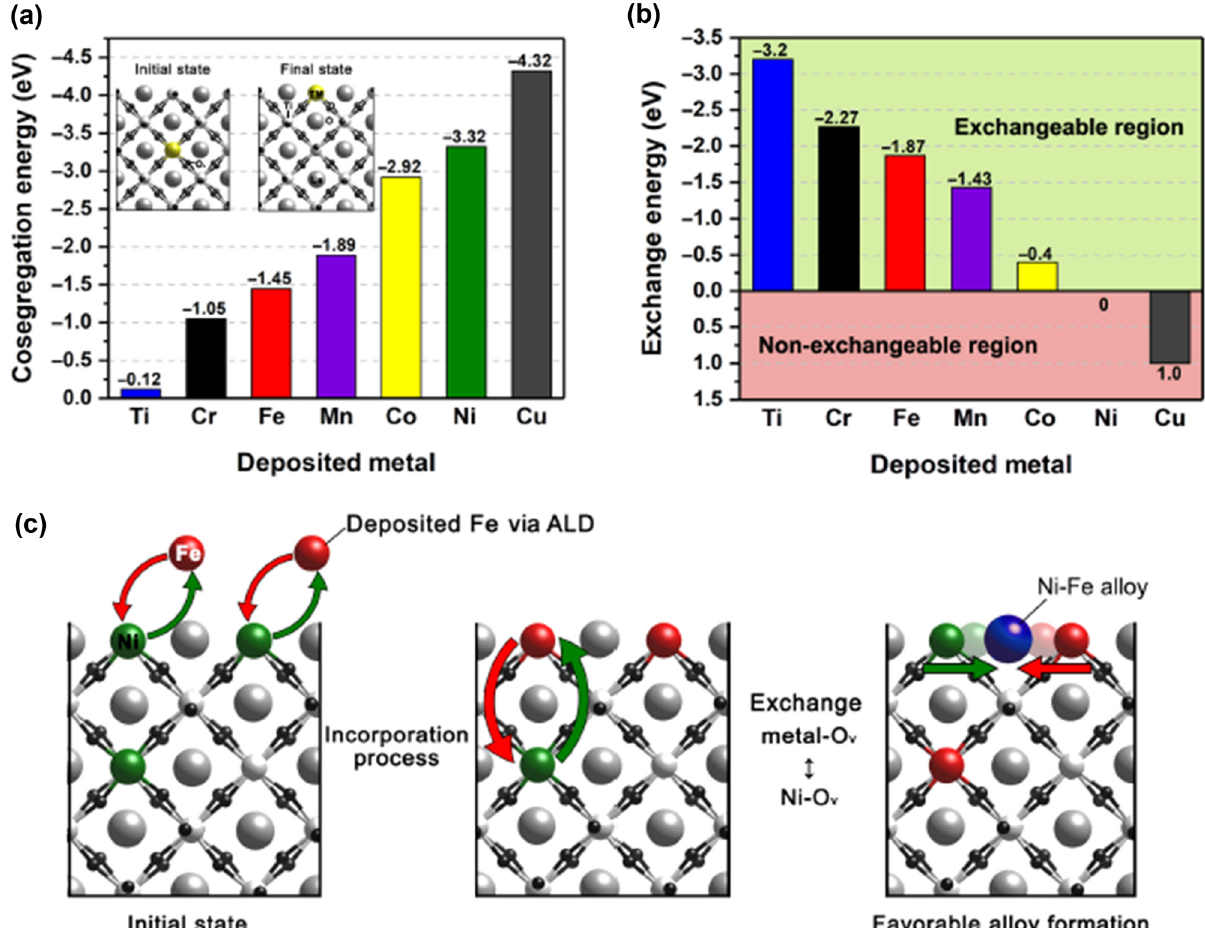
Figure 7: Density functional theory model schematics used to calculate metal co - segregation on the B - site with a cation exchange and O vacancy: ( a ) the co - segregation energy in eV of the deposited metal; ( b ) the exchange energy comparison of the di ff erent deposited transition metals; and ( c ) DFT calculation representations for the cation exchange and alloy formation [ 117 ]